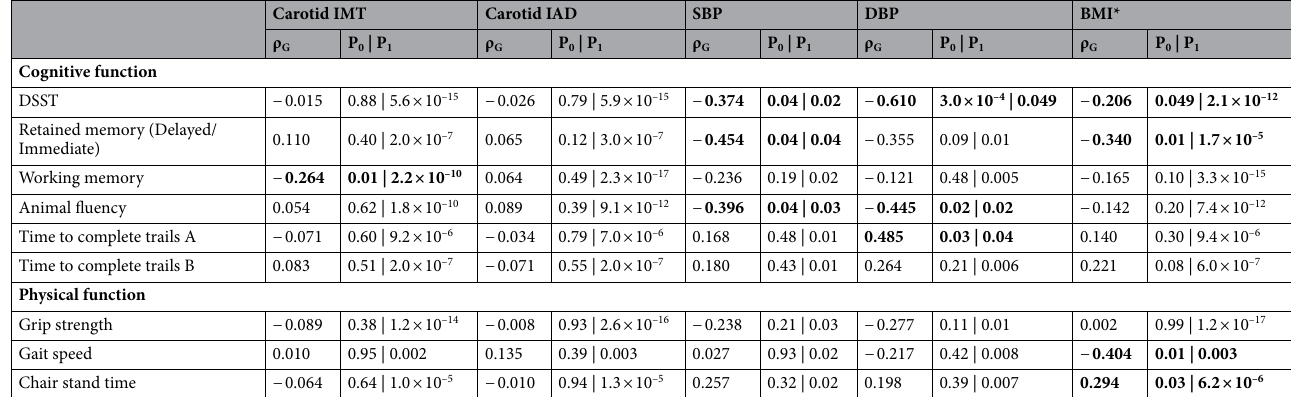
Table 4. Adjusted genetic correlations (ρ G ) between CVD risk factors and cognitive and physical function. Values shown are estimates of the correlation between CVD risk factor and cognitive or physical function measure that is due to genetic factors (e.g., genetic correlation ( ρ G ). P -values are shown both for the test for a significant difference from zero (0) (i.e., some shared genetic variance; P 0 ) and the test of a significant difference from unity (1) (i.e., completely shared genetic variance; P 1 ). To facilitate quick interpretation, all instances of significant genetic correlation are shown in BOLD. Covariate adjustments: age, age 2 , sex, field centers, height, weight, and whether an individual currently smokes. *BMI models do not include adjustment for height or